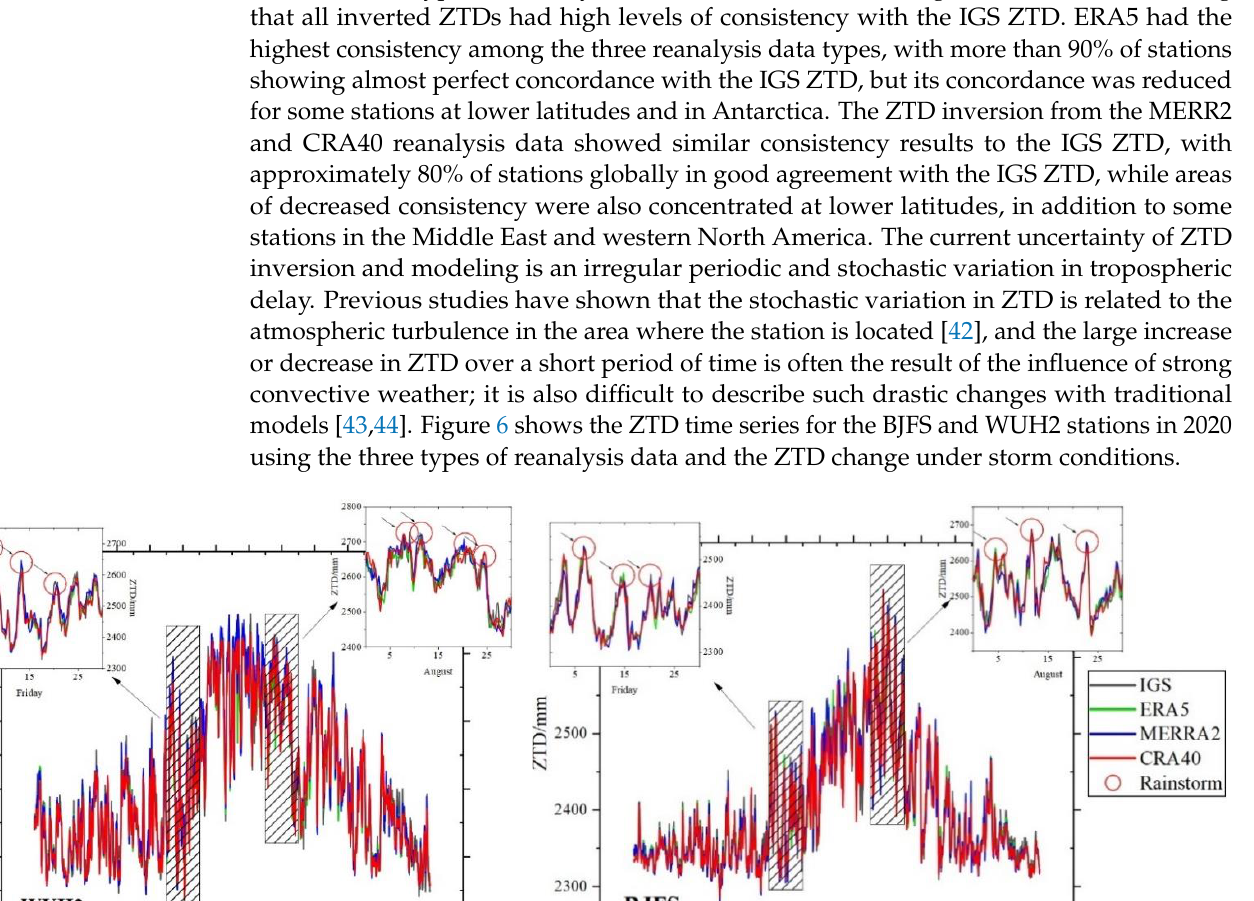
Figure 5. Global consistency distribution of the three inverted ZTDs.